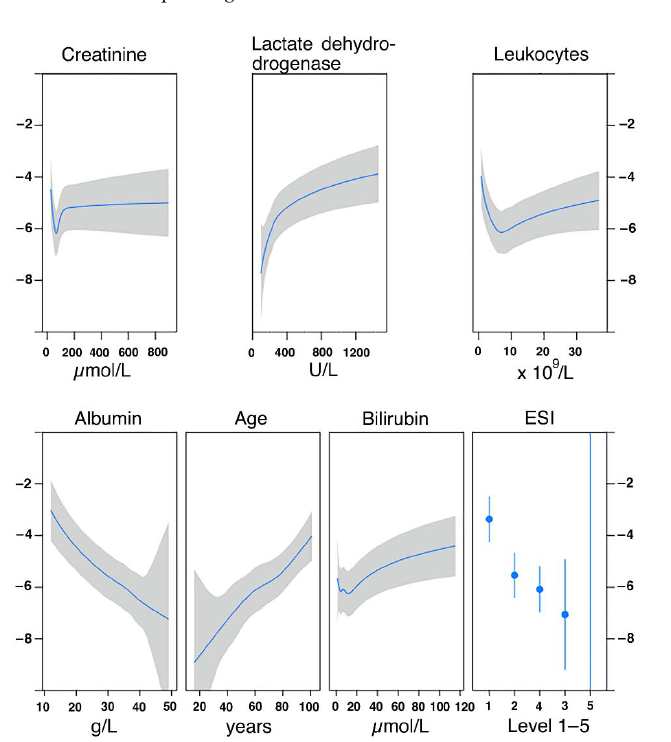
Figure A1. Nonlinear relationships between variables of the reduced model and probability of in-hospital mortality on a log odds scale.